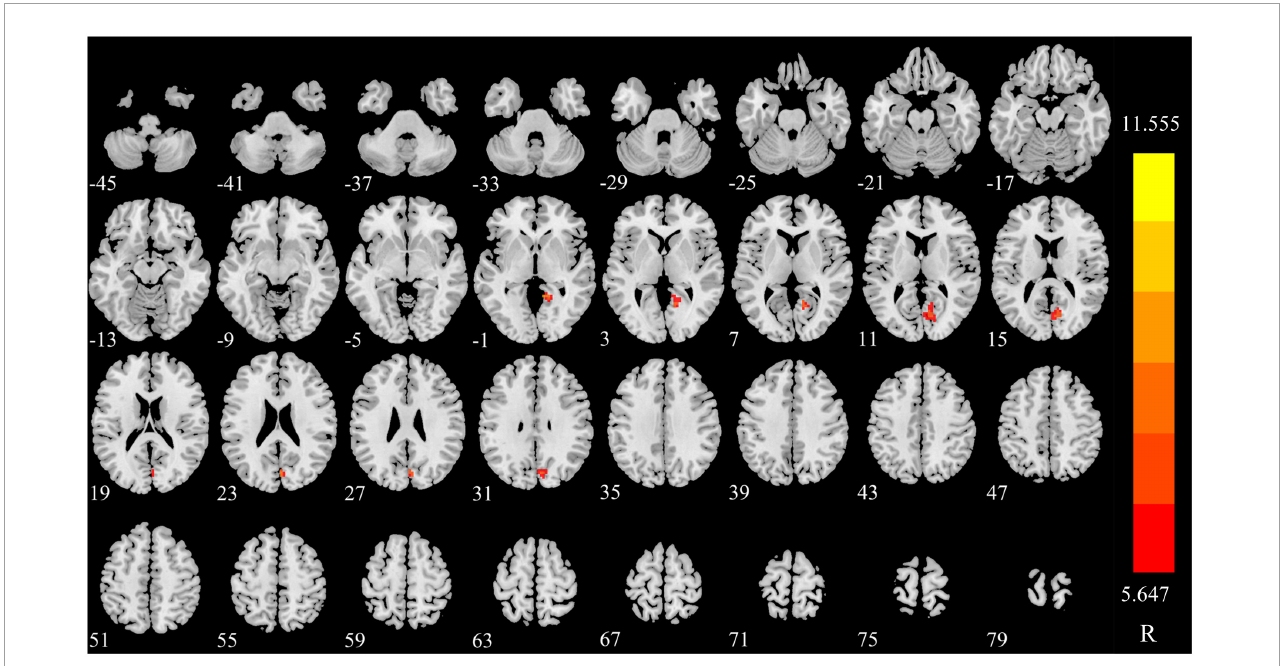
FIGURE4 Significant differences in dDC among different time points in patients with CTN. dDC, dynamic degree centrality; CTN, classical trigeminal neuralgia.